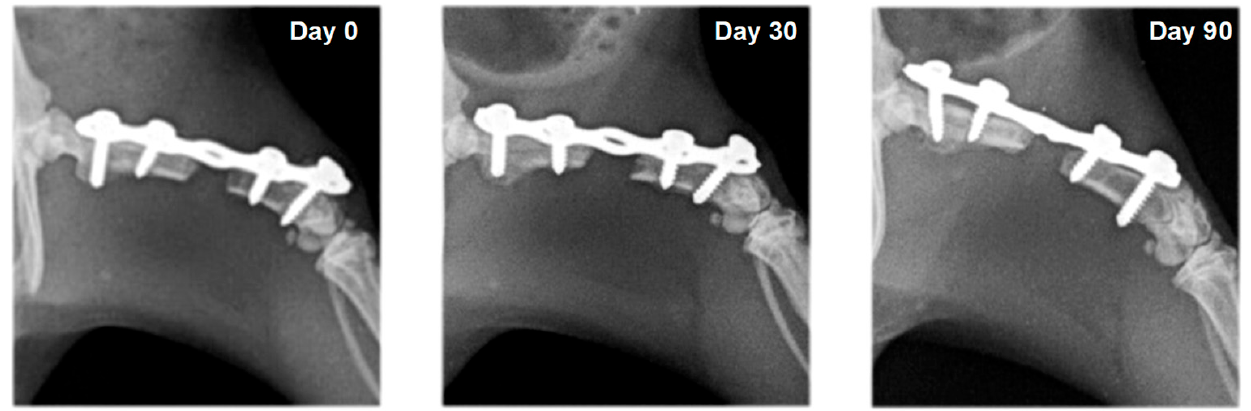
Figure 3. Serial craniocaudal radiographs of rat femurs from experimental group F1 on post-operative days 0, 30 and 90.